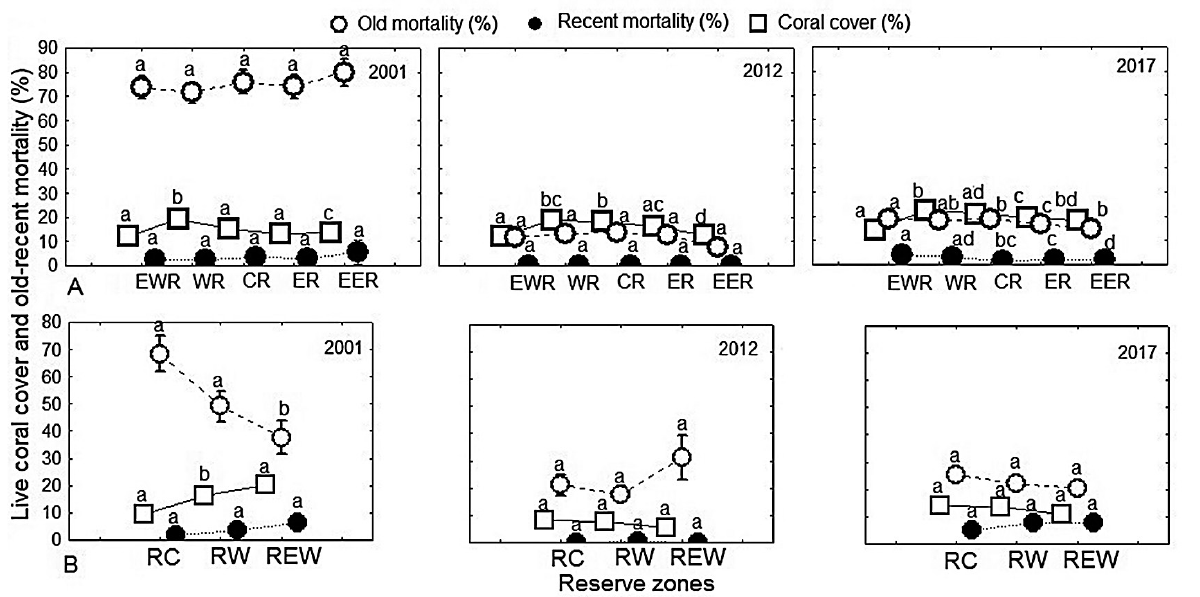
Fig. 6. – Coral cover, old mortality and recent mortality (%) on the fore reef (A) and reef crests (B) (EWR, Westernmost Reserve; WR, Western Reserve; CZ, Central Reserve; ER, Eastern Reserve and EER, Easternmost Reserve). A. 2001: OM (df=4, p-value=0.9054), RM (df=4, p-value=0.9718), live coral cover (df=4, p-value=0.01521). 2012: OM (df=4, p-value=0.2007), RM (df=4, p-value=0.3133), live coral cover (df=4, p-value=3.554e-05). 2017: OM: (df=4, p-value=0.001946), RM (df=4, p-value=0.007323), live coral cover (df=4, p-value=9.758e-09). B. 2001: OM (df=2, p-value=0.02283), RM (df=2, p-value=0.1038), live coral cover (df=2, p-value=0.07346). 2012: OM (, df=2, p-value=0.5809), RM (df=2, p-value=0.619), live coral cover (df=2, p-value=0.05107). 2017: OM (df=2, p-value=0.2334), RM